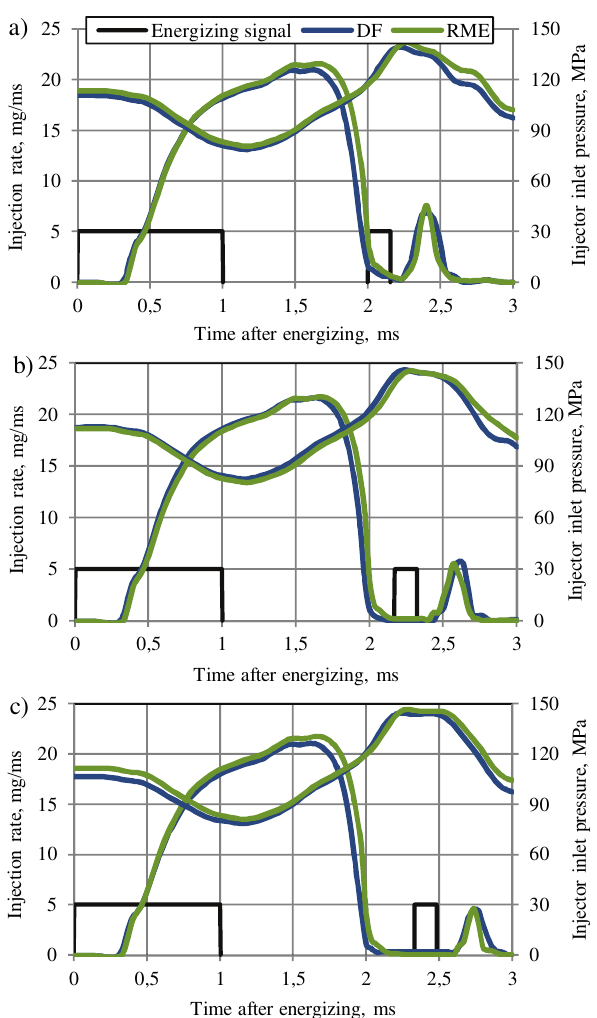
Fig. 4. Effects of fuel types on injector inlet pressure and the injection rate under split injection at the intervals: a – 2.0 ms, b – 2.15 ms, c – 2.3 ms After the injection interval was increased from 0.8